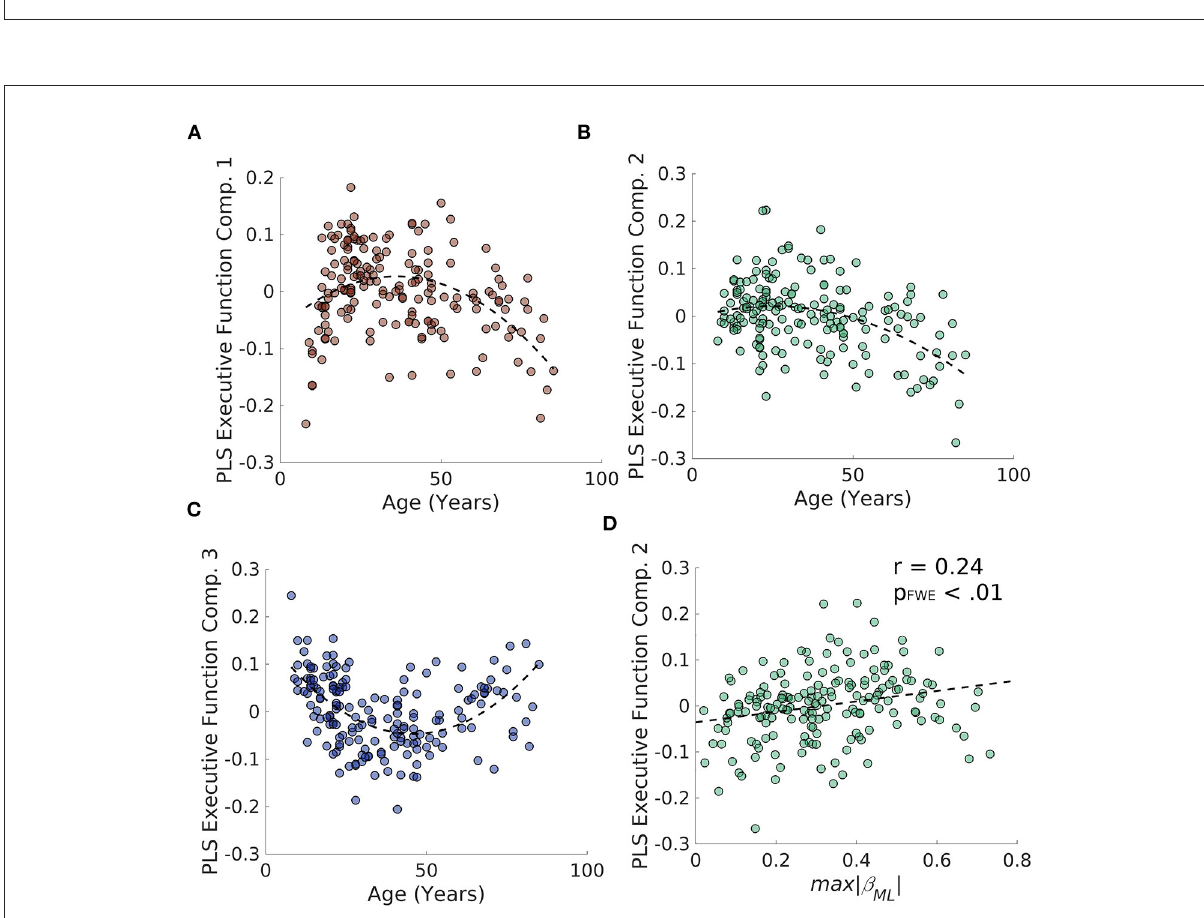
FIGURE6 Results of PLS regression of age polynomial expansion (up to 3rd order) on the D-KEFS inventory for the NKI/Rockland sample. (A–C) The three age-related latent executive function variables plotted across age. (D) The second age-related latent executive function variable significantly correlates with the integrity of the M-L gradient in the